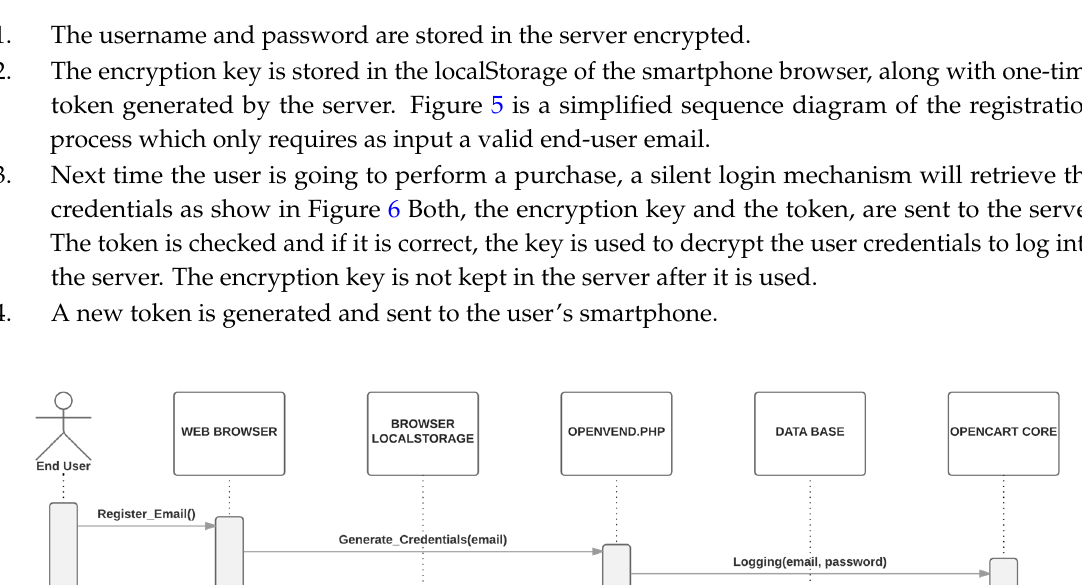
Figure 5. Registration process with end-user email and one-time token.